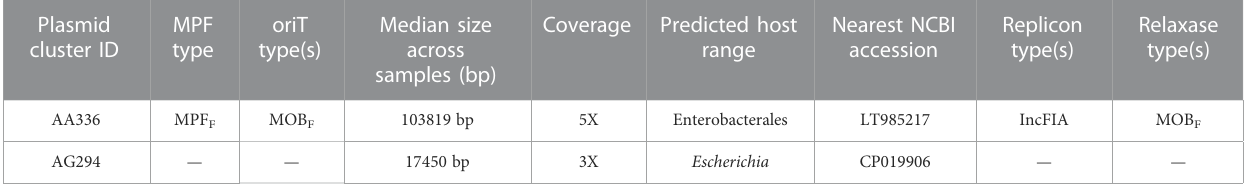
TABLE2ONTadaptivesamplingimproves thedetectionofplasmids.Twoplasmidswereidenti fi edinsample4withadaptivesamplingbutnotwithoutAS.Cluster IDs re fl ect unique taxonomic identi fi ers for plasmids and are stable over time. MRF: Metapair information and oriT: origin of transfer. Plasmid cluster